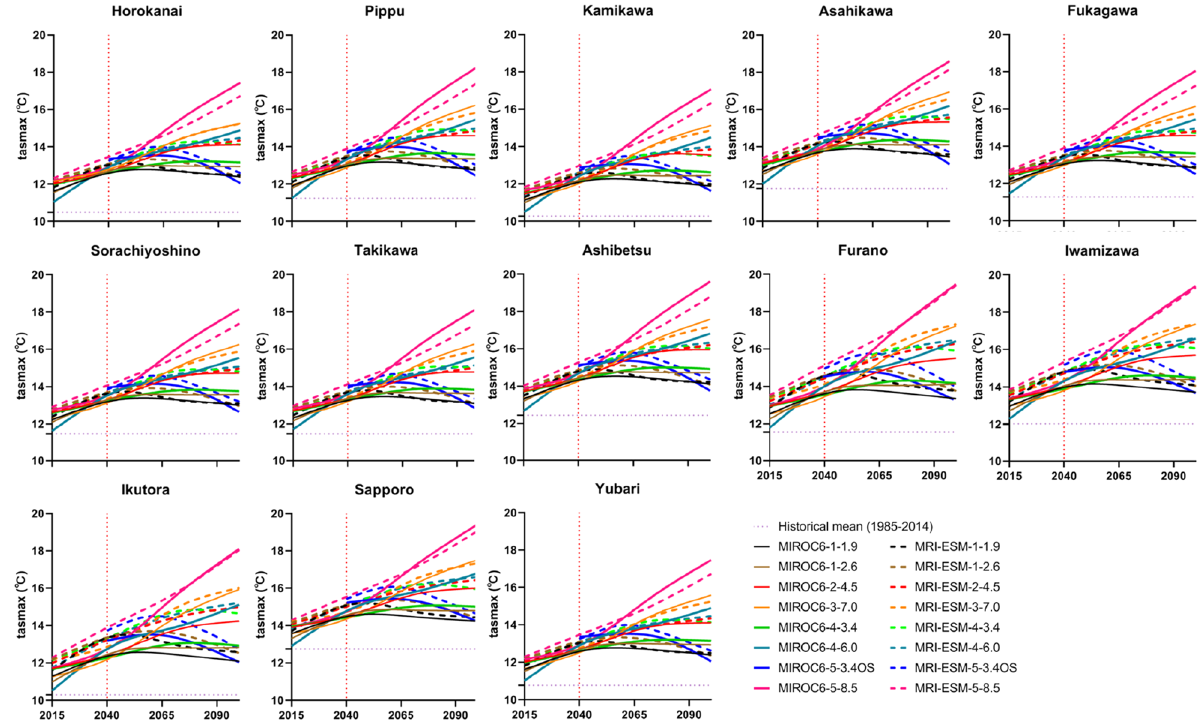
Figure 5. Annual mean maximum temperature (tasmax) under SSP-RCPs scenarios of two GCMs.